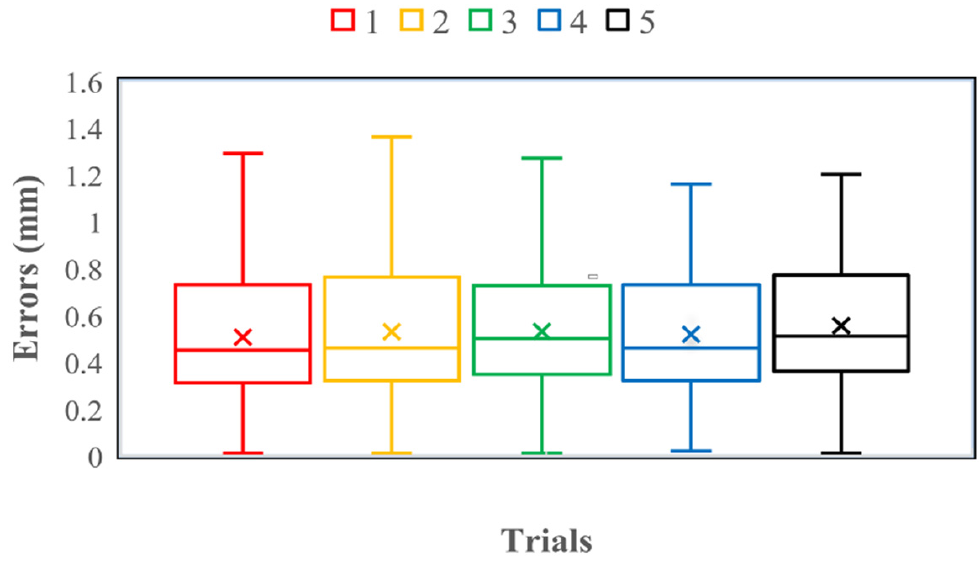
Figure 15. The error of linear tracking after the experiment was repeated five times. Table 2. The statistical result of errors in the system’s linear tracking. Trials